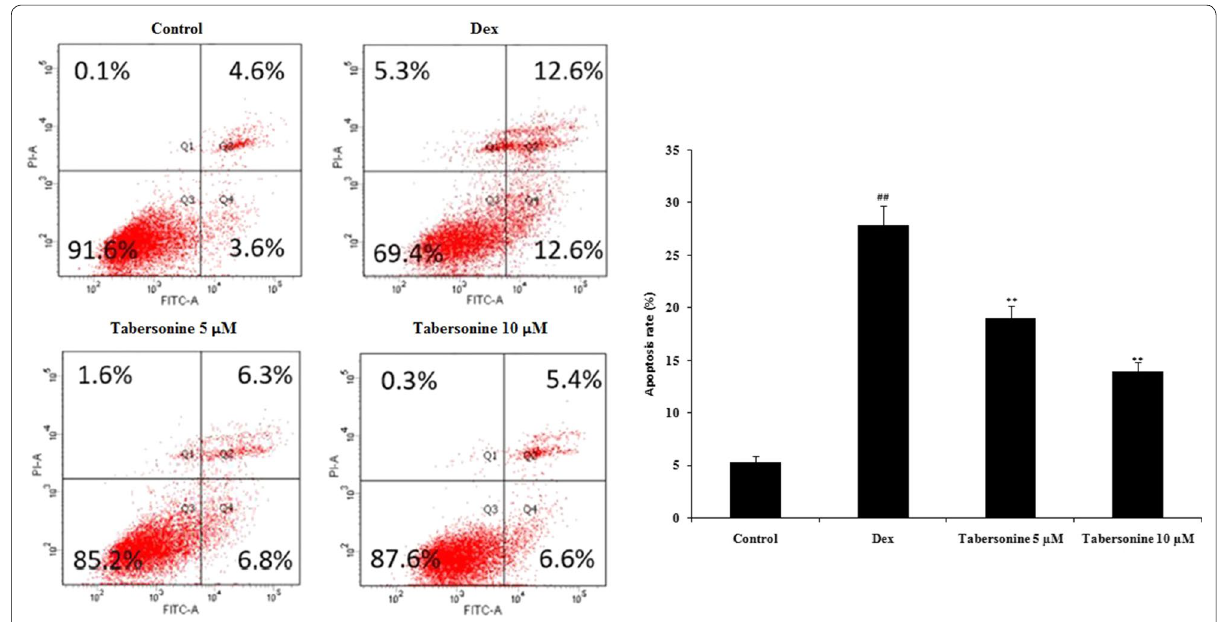
SEMs ( n 10). ## p < 0.01 vs. control, ** p < 0.01 vs. Dex ± =